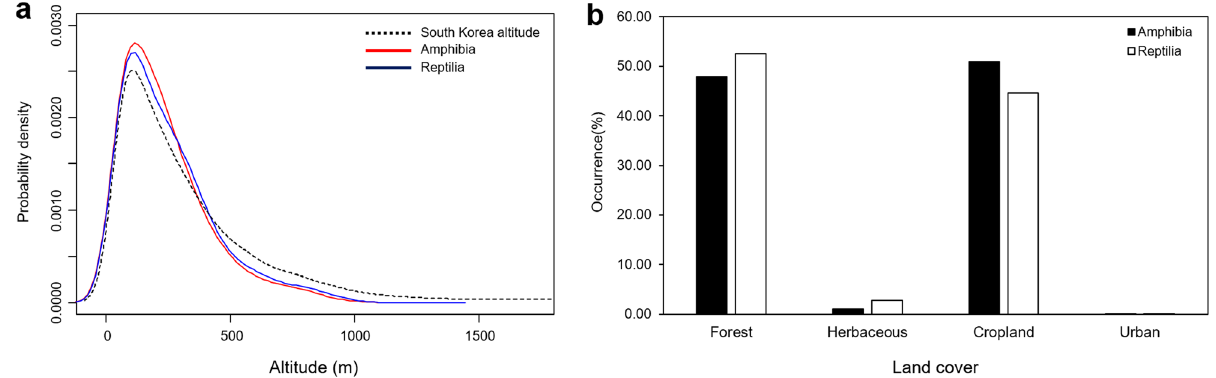
Figure 1. ( a ) Kernel density plot of the occurrence of the 19 amphibian and 20 reptile species according to altitude, ( b ) Graph showing the occurrence of the 19 amphibian and 20 reptile species according to habitat